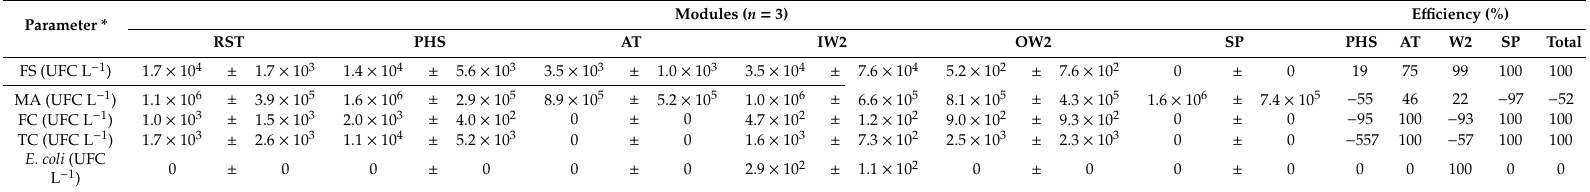
Table 4. Microbiological parameters and e ffi ciencies for each module on planted cell (W2). E ffi ciency is referred to a previous module and total e ffi ciency was calculated SP with respect to